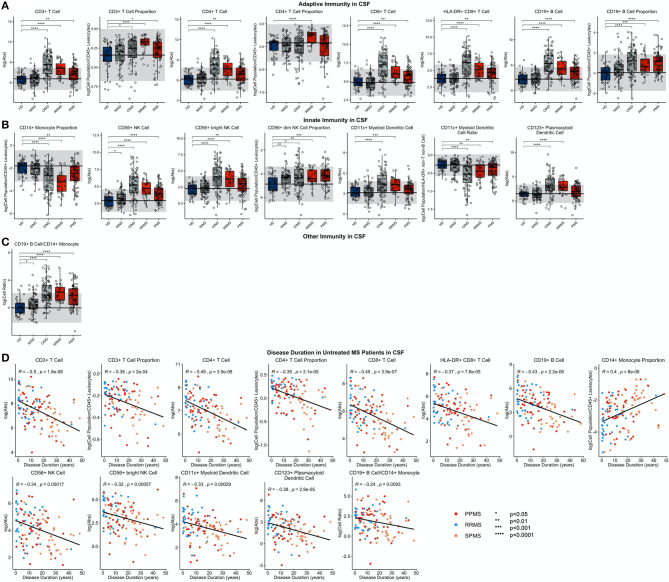
Features that validated in the independent validation cohort in CSF during comparison of HDs to RRMS and PMS patients were graphed. HDs, NINDs, OINDs, RRMS, and PMS cohorts for each significant feature were graphed. An unpaired t-test was completed to compare each cohort to HDs with adjustment for multiple comparisons. *p < 0.05, **0.01 < p < 0.005, ***p < 0.001, ****p < 0.0001. The HD median for each feature was also graphed horizontally and gray shading added representing ± 2 SDs of each feature in HD cohort. (A) Features in adaptive immunity. (B) Features in innate immunity. (C) Features in other immunity. (D) Features that validated were correlated with disease duration and statistically significant features graphed (p ≤ 0.05). MS subtypes were color coded to show heterogeneity of cohorts in each significant feature with blue representing RRMS, red representing PPMS, and orange representing SPMS patients.